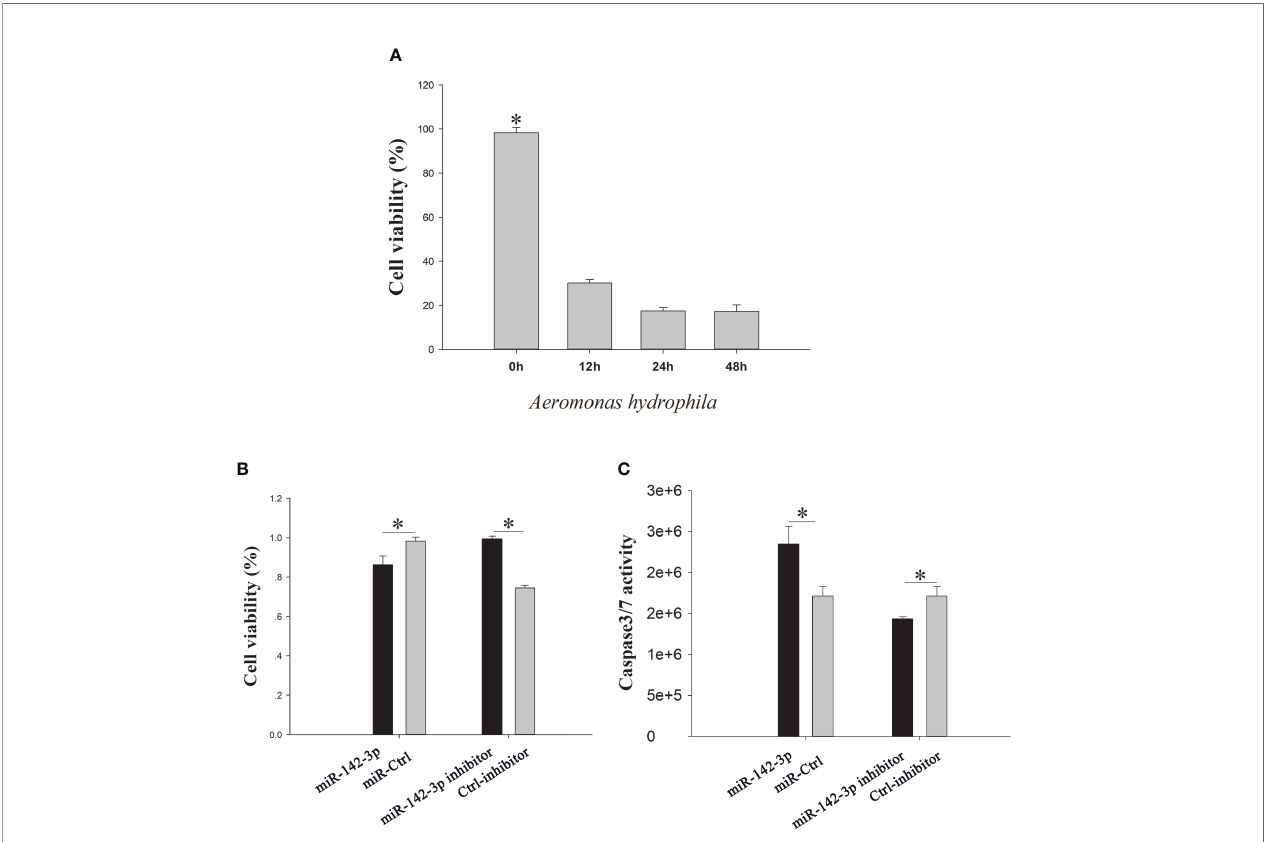
FIGURE 4 | (A) grass carp kidney (CIK) cells were treated with A. hydrophila , the cell counting kit-8 (CCK8) assay was used to evaluate cell viability. (B) CIK cells were transfected with miR-142a-3p agomir or antagomir, and the CCK8 assay was used to evaluate cell viability. (C) The caspase-Glo 3/7 kit was used to detect the caspase 3/7 activity. All values represent the mean ± SD of three independent experiments. * p <